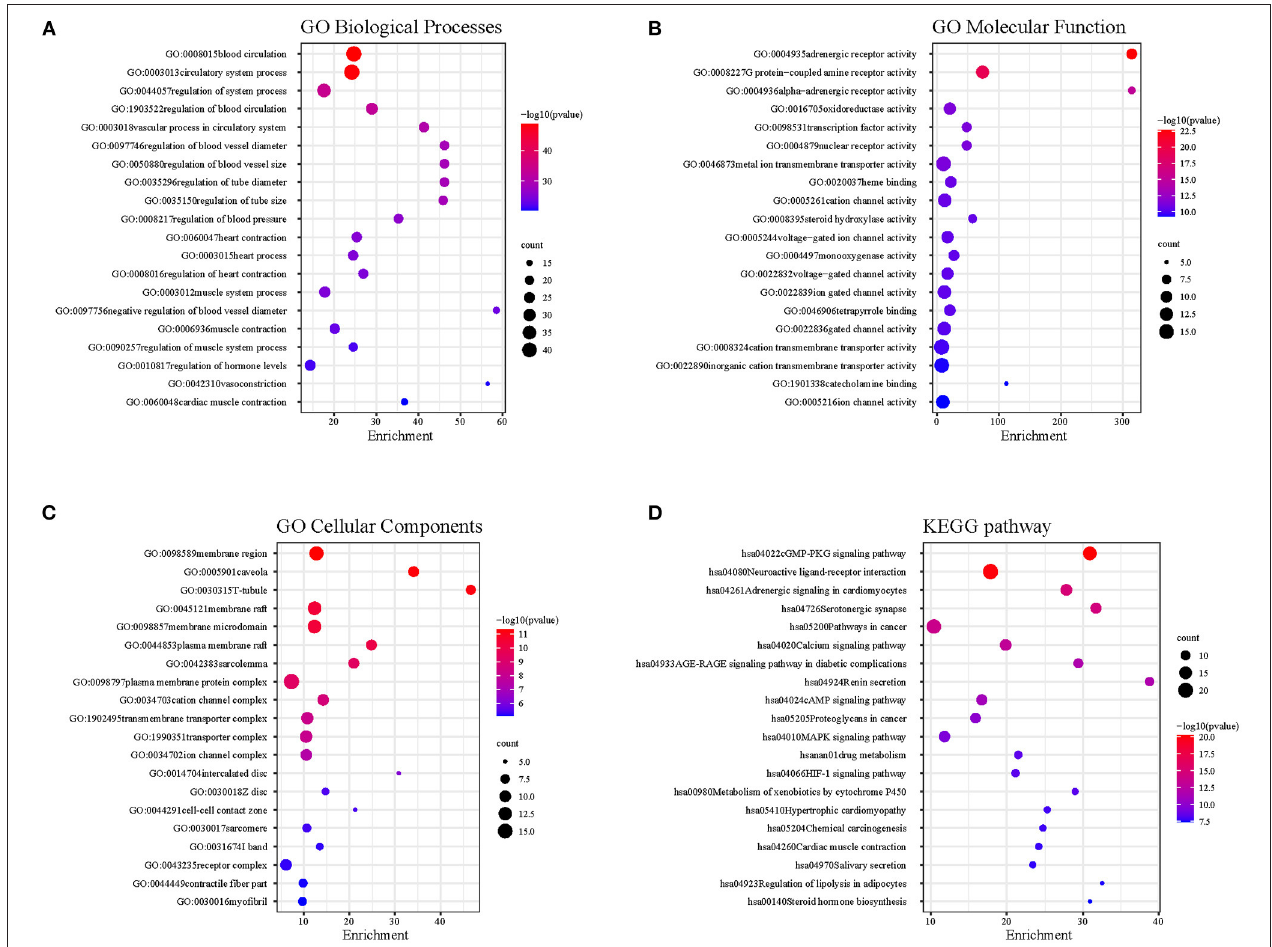
FIGURE 5 | The functional enrichment analysis. (A) GO Biological Processes. (B) GO Molecular Function. (C) GO Cellular Components. (D) KEGG